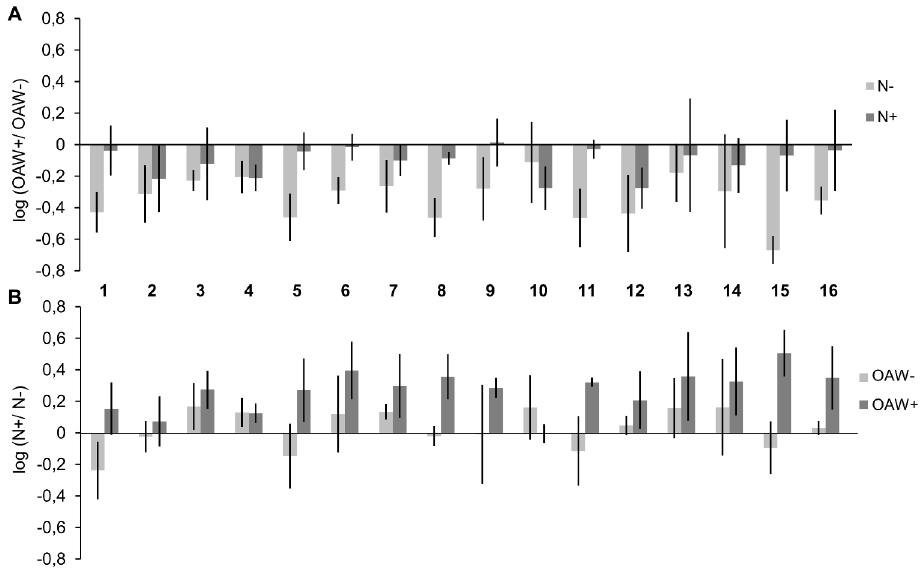
Fig 3. Log effect ratios of growth in 16 sibling groups during the OAW x nutrient experiment. Log effect ratios (mean ± 95% confidence intervals, n = 3) of (A) OAW effects were calculated as log (growth OAW+/ growth OAW-) under ambient and high nutrient conditions (N-, N+) and (B) log effect ratios for nutrient effects calculated as log (growth N+/ growth N-) at ambient and high OAW (OAW-, OAW+).